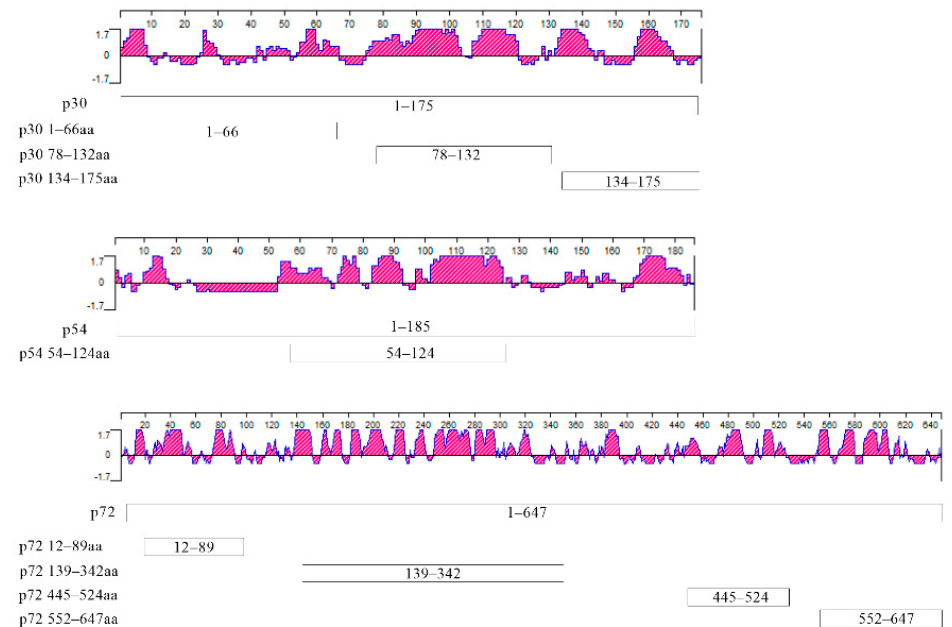
Figure 1. Jameson–Wolf protein antigenicity profile for p30, p54 and p72. The X–axis values are amino acid residues for each protein; the Y–axis represents the antigenic index (Jameson and Wolf, 1988). Positions of each truncated recombinant proteins are shown in boxes. p30 1–66aa, 78–132aa